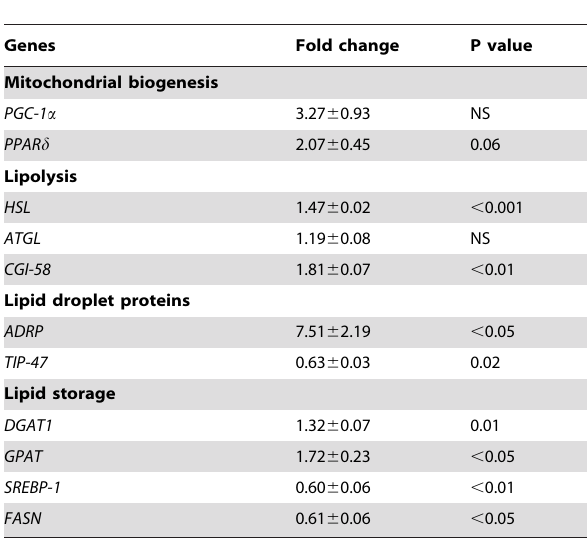
Data are expressed as mean 6 SEM of 4 separate experiments. NS: not significant. PGC-1 a , peroxisome proliferator activated receptor coactivator-1 a ; PPAR d , peroxisome proliferator activated receptor d ; HSL, hormone sensitive lipase; ATGL, adipose triglyceride lipase; CGI-58, comparative identification gene 58; ADRP, adipose related differentiation protein; TIP-47, tail interacting protein of 47 kDa; DGAT1, diacylglycerol acyl-transferase 1; GPAT, glycerol-3- phosphate acyl-transferase; SREBP-1, sterol responsive element binding protein- 1; FASN, fatty acid synthase. (Fig. 3B), as well as in the perinuclear region as revealed by co- staining of nuclei with DAPI (Fig. 3D). Image quantification